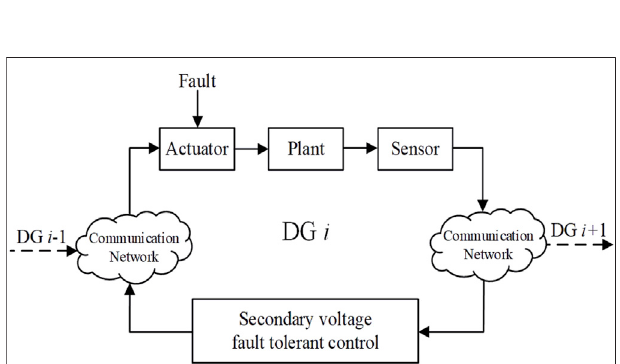
FIGURE 2 | Block diagram of an inverter-based DG and control.